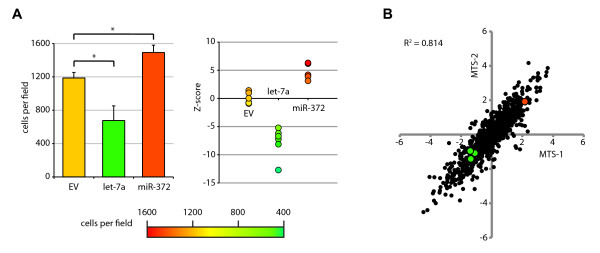
Arrayed screening using the lentiviral library. (A) A375 cells were seeded in a 96-well plate and infected with virus containing an empty vector, let-7a, or miR-372. Five days after infection, cells expressing let-7a were significantly less numerous than cells expressing empty vector, while cells expressing miR-372 were significantly more numerous (left panel, * indicates p < 10-4 in a two-tailed t-test). Values are average number of cells per well ± standard deviation, n = 6. Each measurement of both let-7a and miR-372 samples is separated from the empty vector samples by more than three standard deviations (Z-score, right panel). (B) Results of an arrayed screen on cell viability of A375 cells. Cells in individual wells were infected with single miRNA constructs and subjected to an MTS assay 5 days after infection. The screen was performed in duplicate. For each measurement a B-score was calculated. Correlation between duplicate B-scores is shown. The green dots represent let-7a-1, -2, and -3, while the red dot represents miR-372.